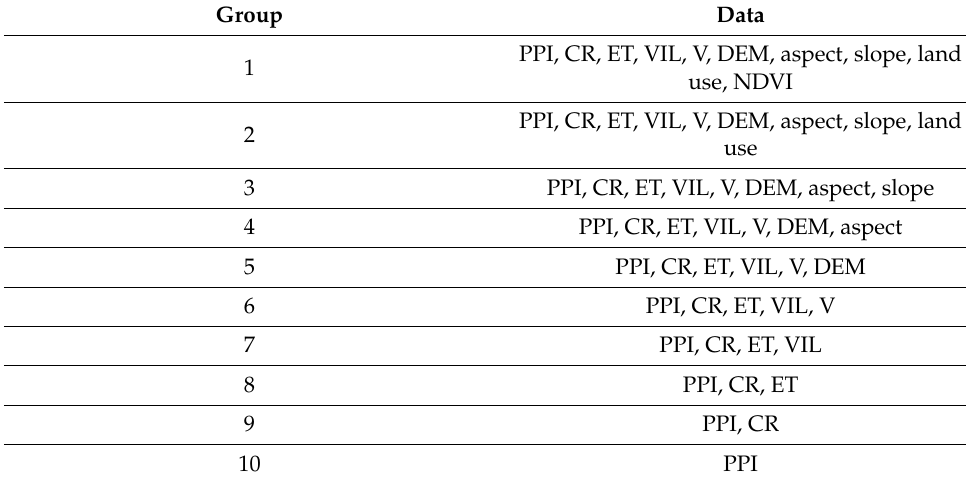
Table 2. Data are shown in different groups.